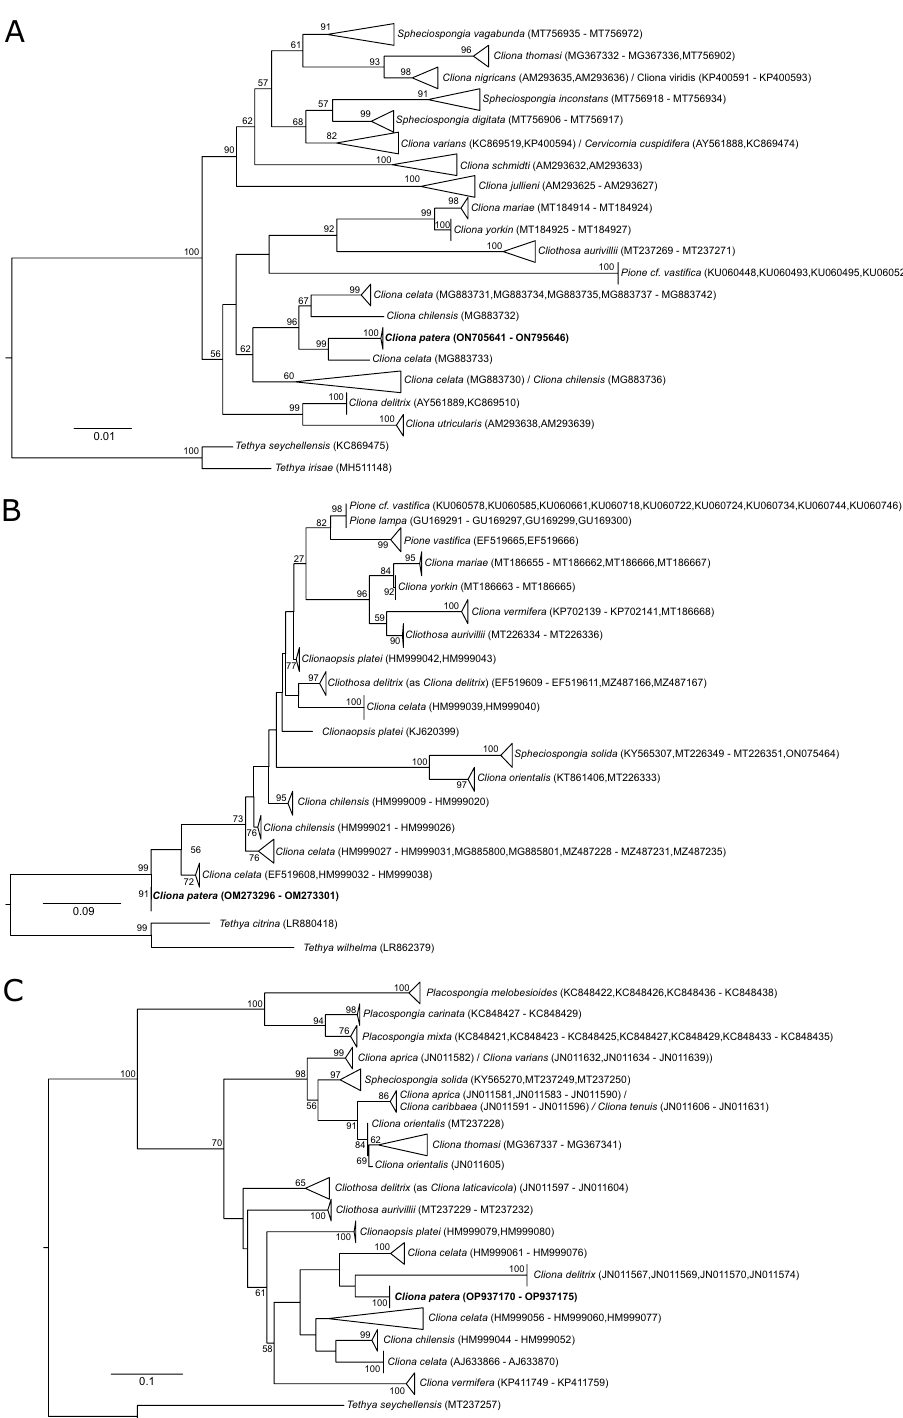
overlapping regions between the sequences downloaded from GenBank with the assembled ribosomal sequences, we repeated the BLASTn search and extracted the overlapping region with the highest bitscore from the contig.